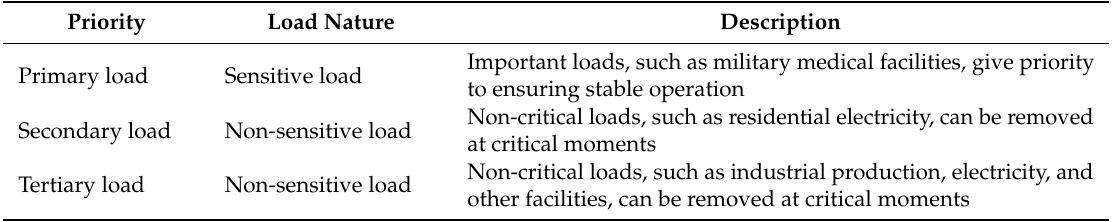
Table 1. Load prioritization.